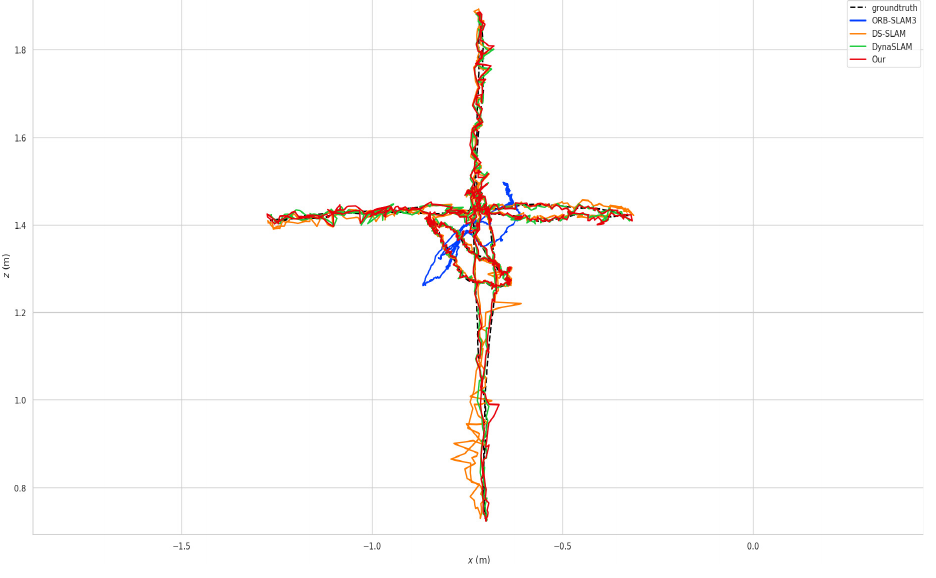
Figure 7. Comparison of trajectory.